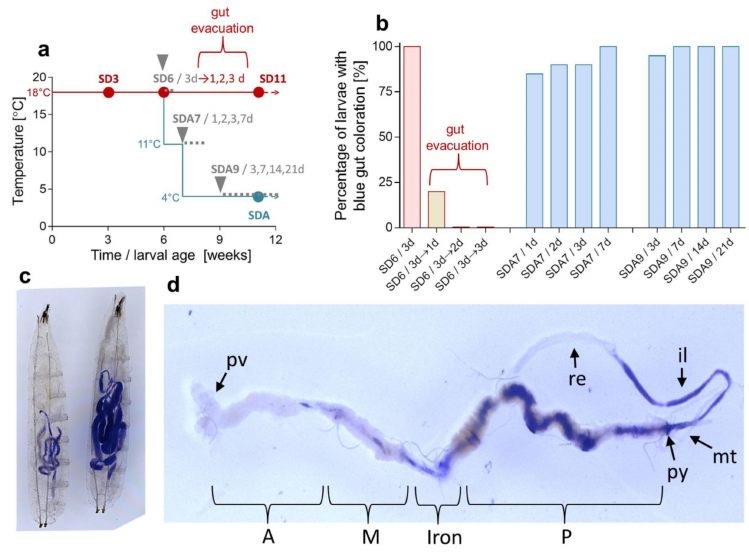
Figure 3. Diet consumption in diapause, of cold-acclimated larvae of C. costata . ( a ) shows the times when larvae were transferred to BB-augmented diets (grey triangles) and for how many days (grey font). Each column in ( b ) shows the percentage of larvae ( n = 20 each) with blue gut contents. SD6 larvae exposed to BB diet for 3 d (all guts blue-colored) were returned to a standard diet to show that the blue coloration disappears in 80% of individuals within 1 d, and in all individuals within 2 d (gut evacuation). Most of the diapausing, cold-acclimated larvae (SDA7 and SDA9) exhibit blue guts within a few days of exposure to the BB diet. ( c ) shows examples of BB diet-fed larvae: left, an SDA9 larva exposed to BB diet for 14 d at 4 ◦ C; right, a non-diapause (LD) larva exposed to BB diet for 1 h at 18 ◦ C. ( d ) shows a gut dissected from an SDA larva exposed to the BB diet. Gut segments are described according to the gut morphology of D. melanogaster larvae: pv, proventriculus; A, M, P, anterior, middle, and posterior midgut; Iron, iron cells segment; py, pylorus; mt, Malpighian tubules; il, ileum; re,